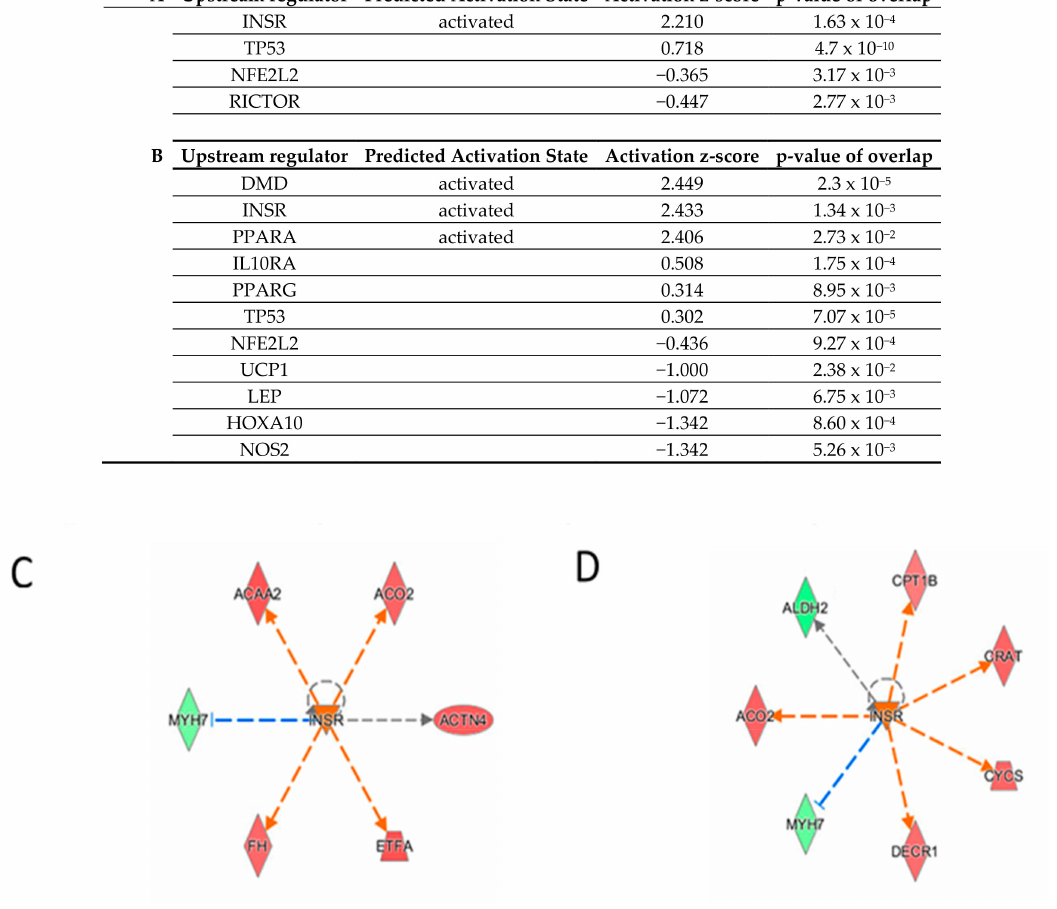
Figure 6. Upstream analysis of DEPs from NaI vs. CTRL set ( A ) and ICM vs. CTRL set ( B ). Activated (z-score ≥ 2) and inhibited (z-score ≤ − 2) upstream regulators are highlighted in orange and blue, respectively. ( C , D ) INSR regulated proteins in NaI and ICM treatments. Up-regulated and down-regulated proteins are highlighted in red and green, respectively, and the color depth is correlated to the fold change. Orange and blue dashed lines with arrows indicate indirect activation and inhibition, respectively. Gray dashed lines with arrows depict no